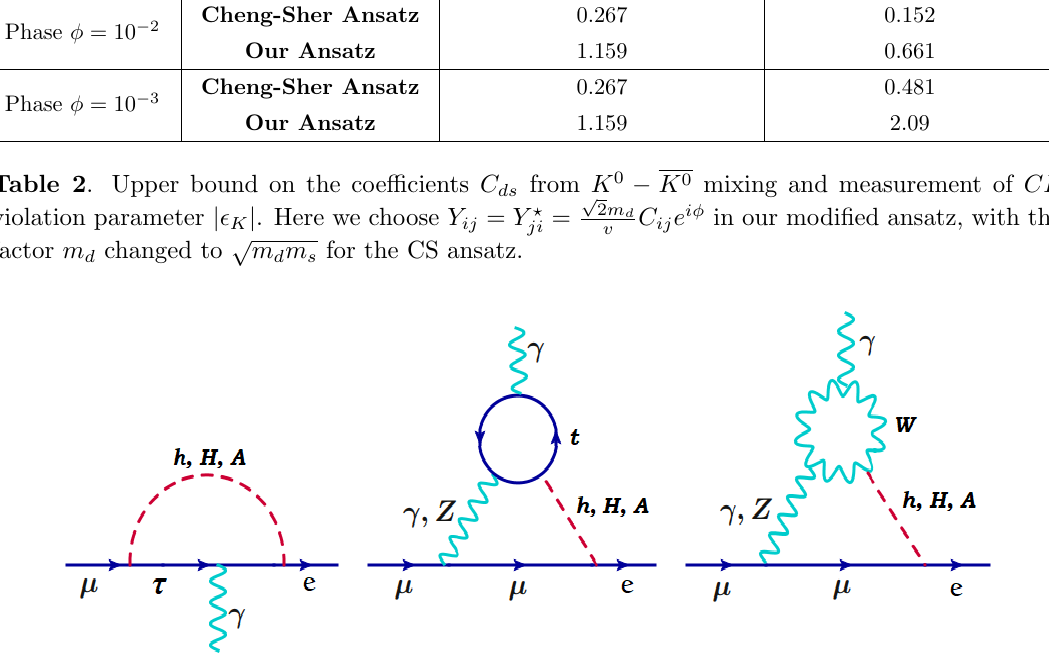
Figure 2 . Representative one and two loop Feynman diagrams contributing to ( (cid:22) ! e(cid:13) ) process in the